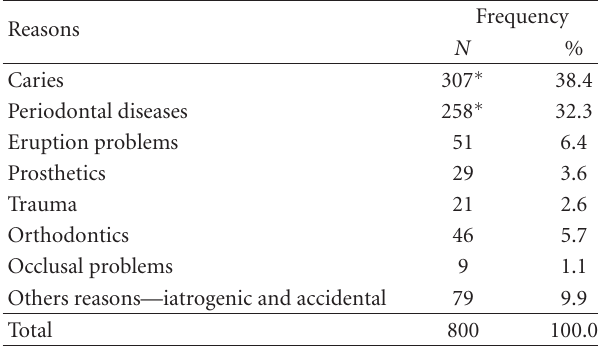
Table 5: Reasons for teeth extractions ( N : number; %